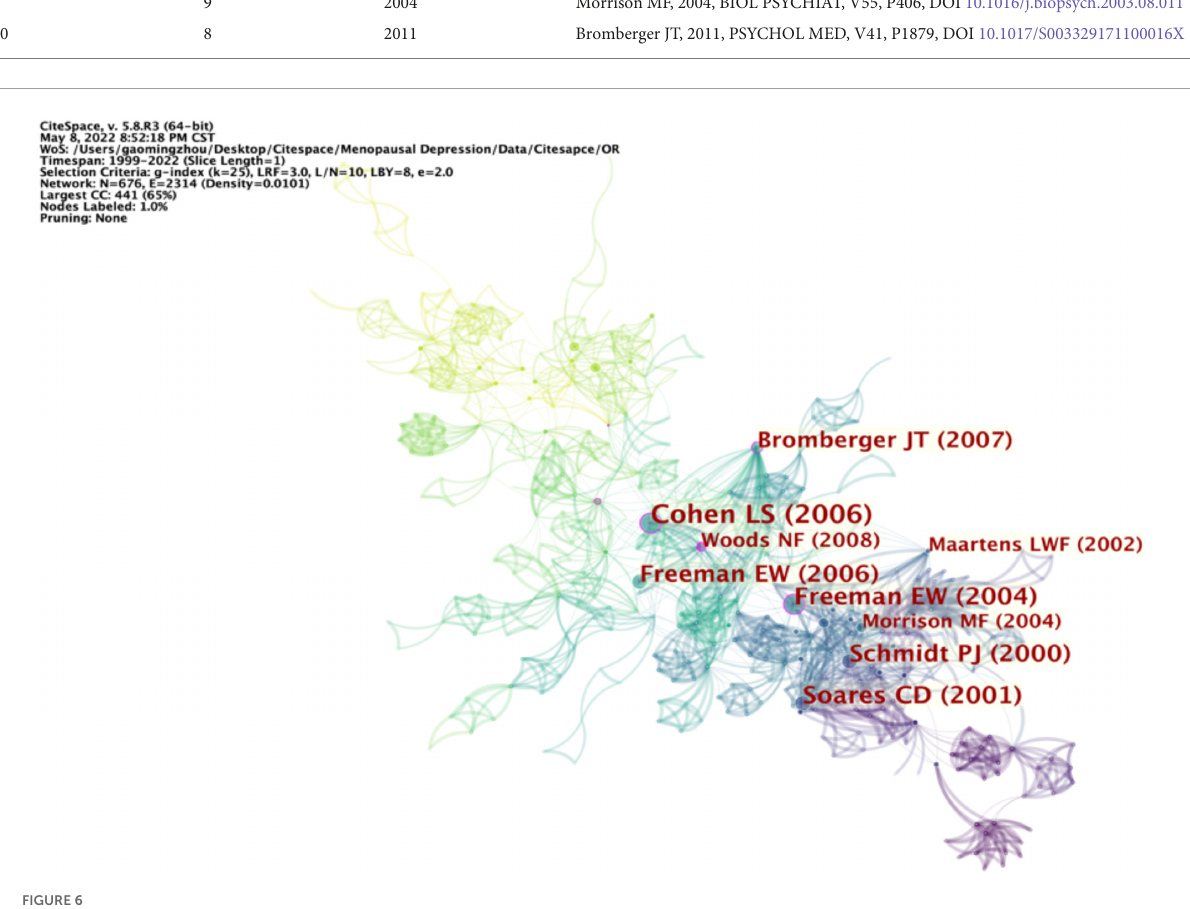
FIGURE6 Visualization map of references involved in